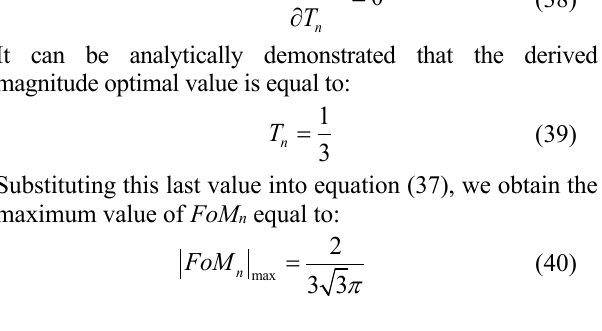
Fig. 4 represents the respective shapes of FoM n and of